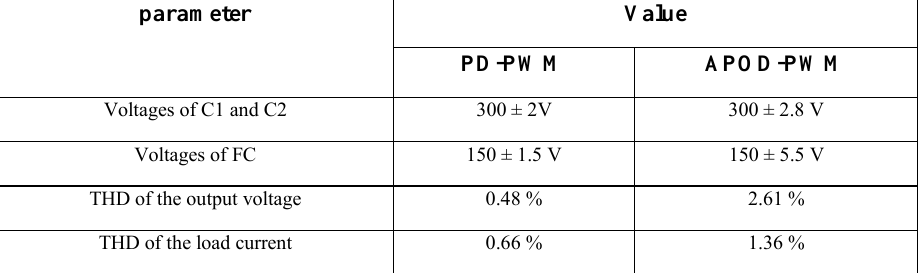
TABLE 3. Performance